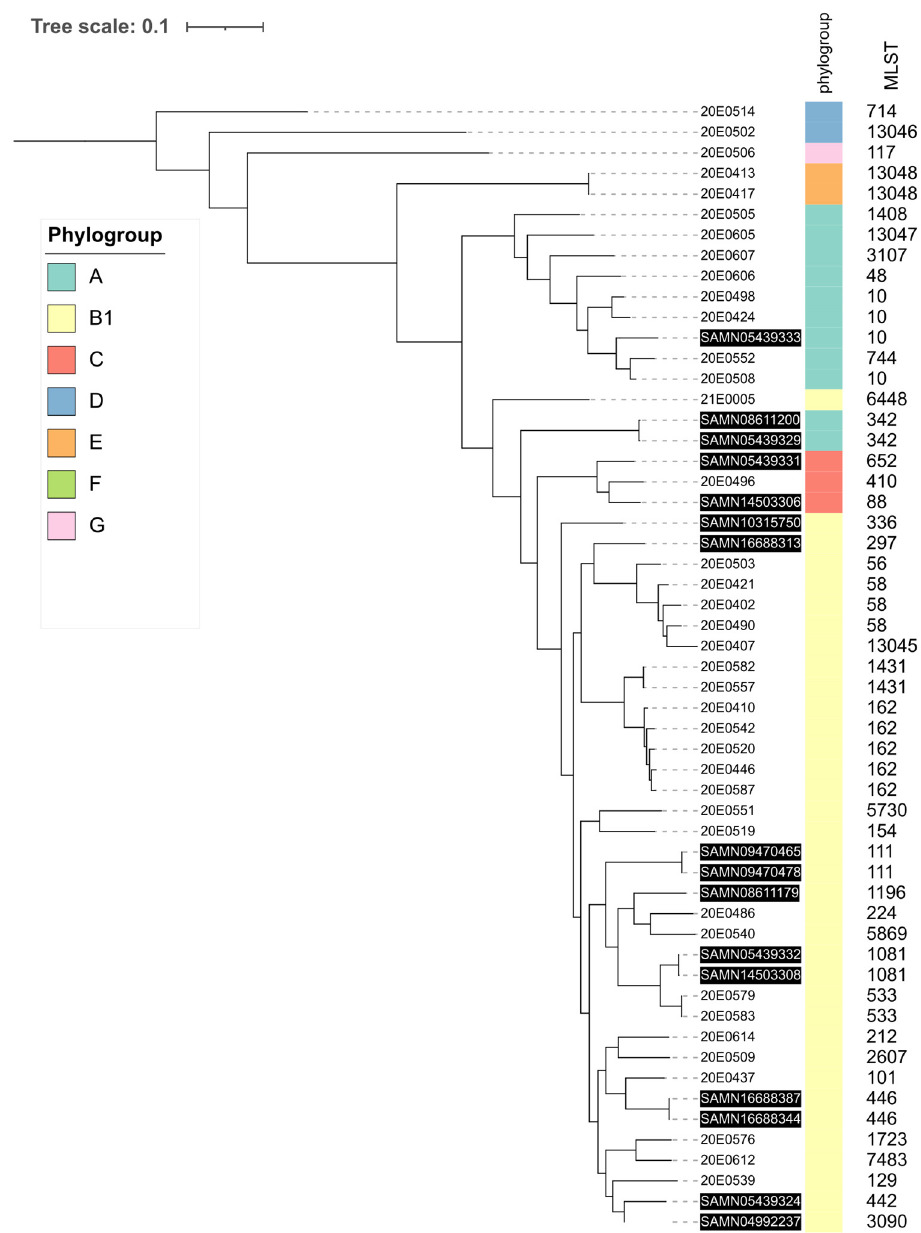
Figure 7. Whole-genome sequencing tree with the 39 E. coli strains of this study and 17 E. coli strains isolated from SAC in Peru and the USA and deposited in Enterobase (inverse type). The phylogroups are represented by different colors, and the multi-locus sequence typing (MLST) assignments are shown on the right. The image was generated with ITOL (v.6).